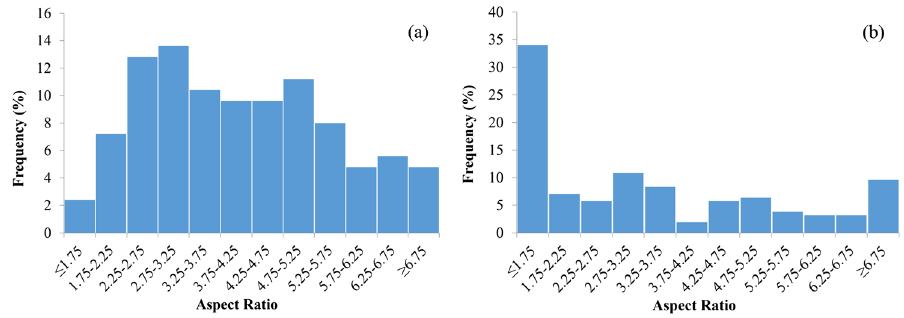
Figure 4. Histogram of aspect ratio before ( a ) and after ( b ) laser irradiation. Nanorods with aspect ratio near 4 reduces in portion, while significant amounts of nanorods with larger aspect ratio (> 6.75) remain.